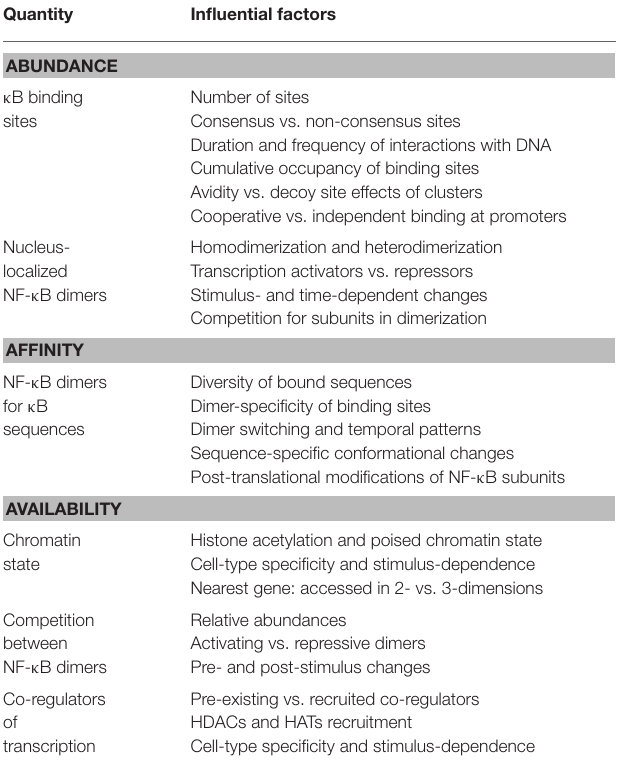
TABLE 1 | Summary of layers of regulations influencing NF- κ B-driven gene